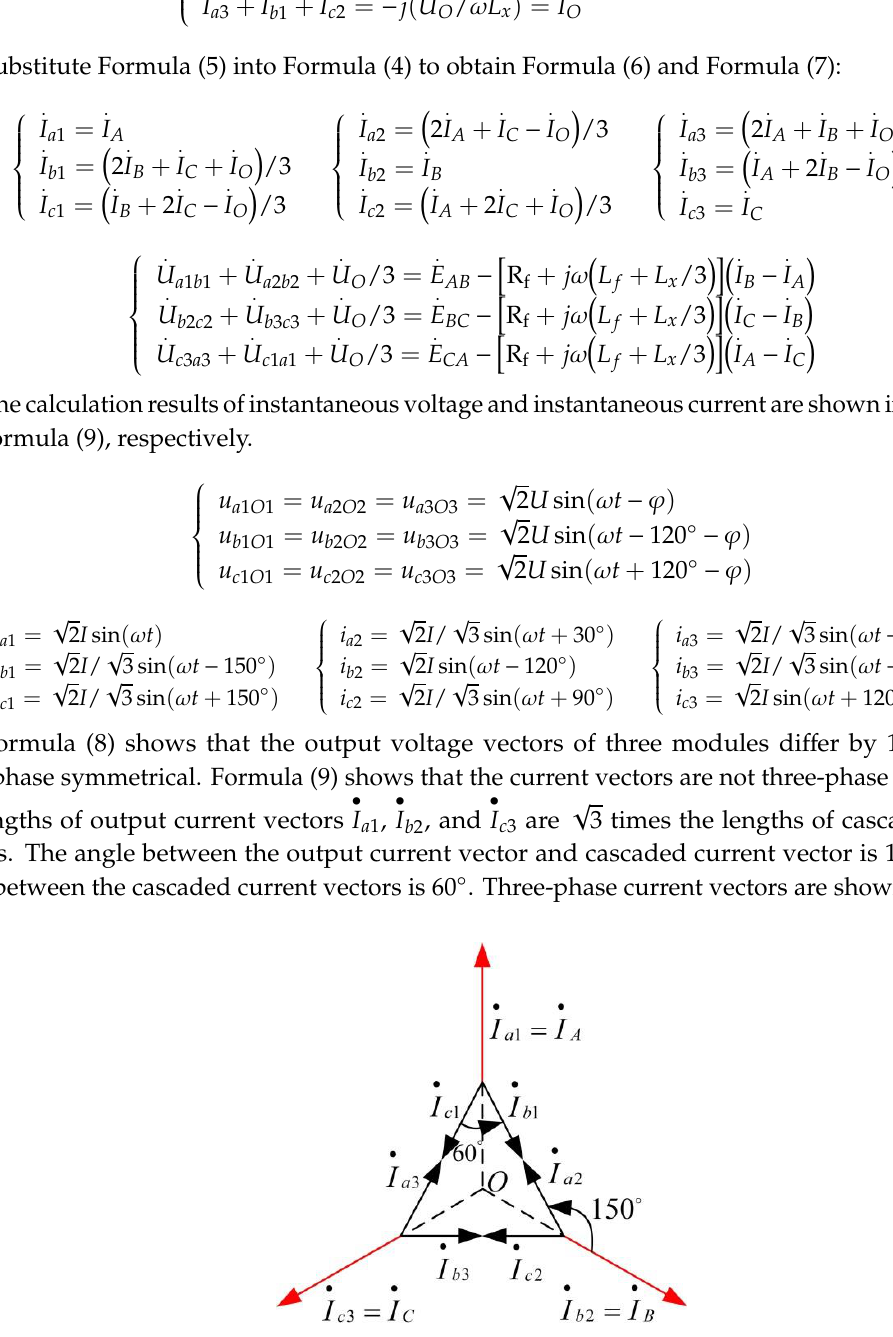
Figure 3. Three-phase current vectors.